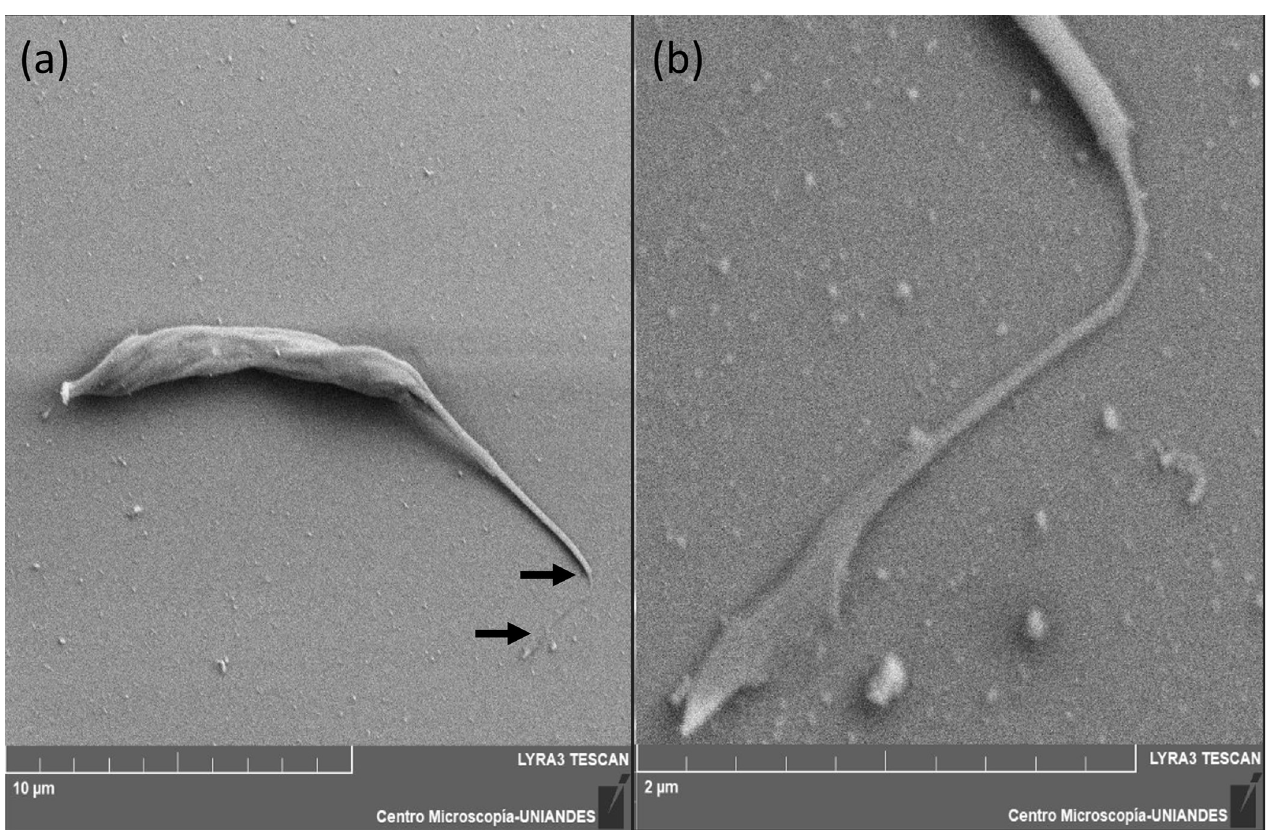
Fig 2. Electron microscopy images of a shear-stress generated nanotubule. (a) An epimastigote after being stretched at 1.24 pN/ μ m 2 . The nanotubule is delimited by black arrows. (b) Detailed view of the nanotubule in (a). Note the anchoring pad at the end of the structure and the funnel shape on the flagellum